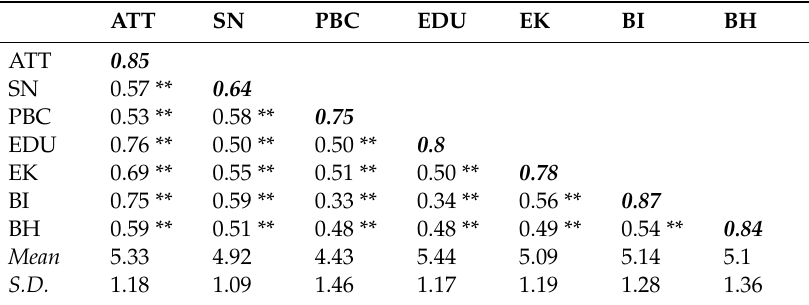
Table 3. Means, standard deviations, and correlations between the constructs.